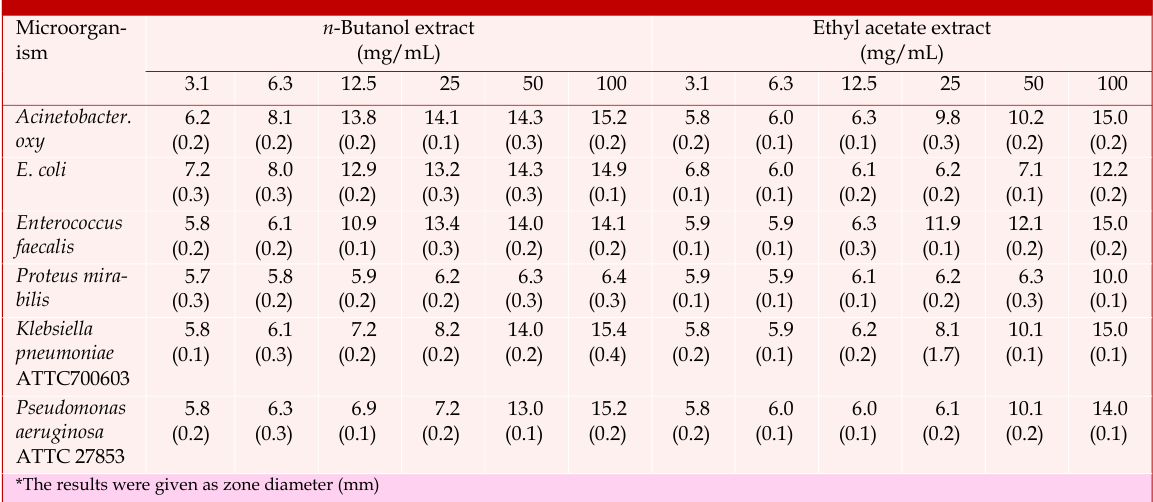
presented in Table III. The aerial parts of the extracts generally showed increase activity with increasing of the concentration against Gram positive bacteria and Gram negative bacteria. Both of the crude extracts exhibited the highest activity against Klebsiella pneumo- niae (15 mm at 100 mg/mL).